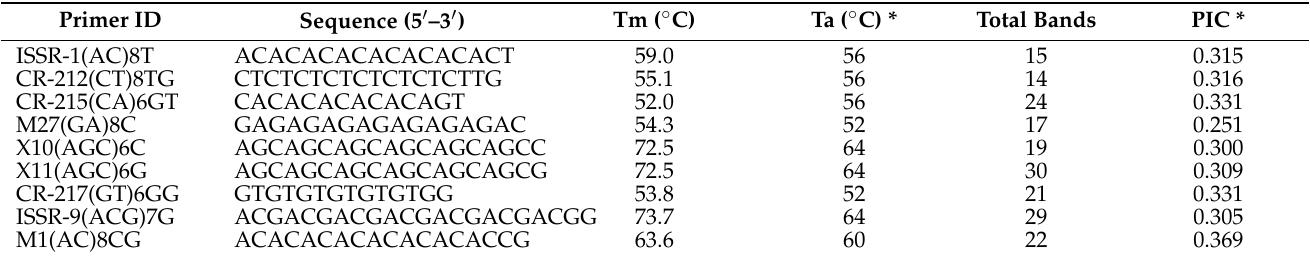
Table 1. The information of ISSR primers used to assess the genetic diversity of Pinus